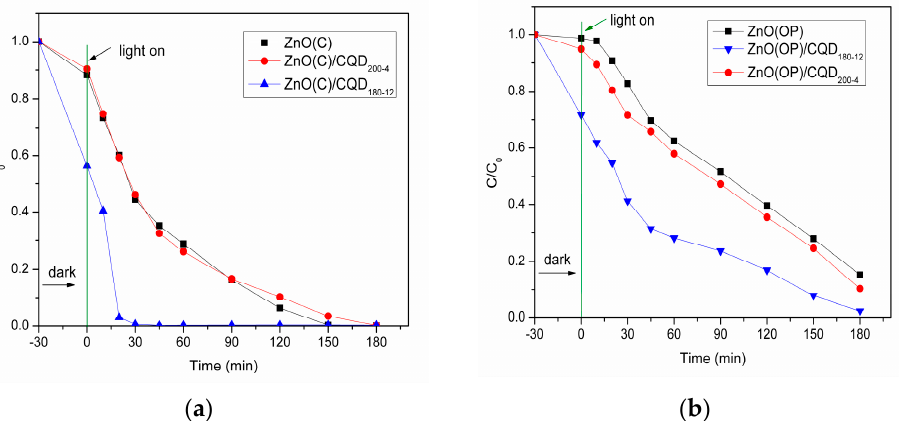
Figure 12. The degradation of MB (665 nm band) in time in the presence of ( a ) ZnO(C)/CQD and ( b ) ZnO(OP)/CQD under UV irradiation.